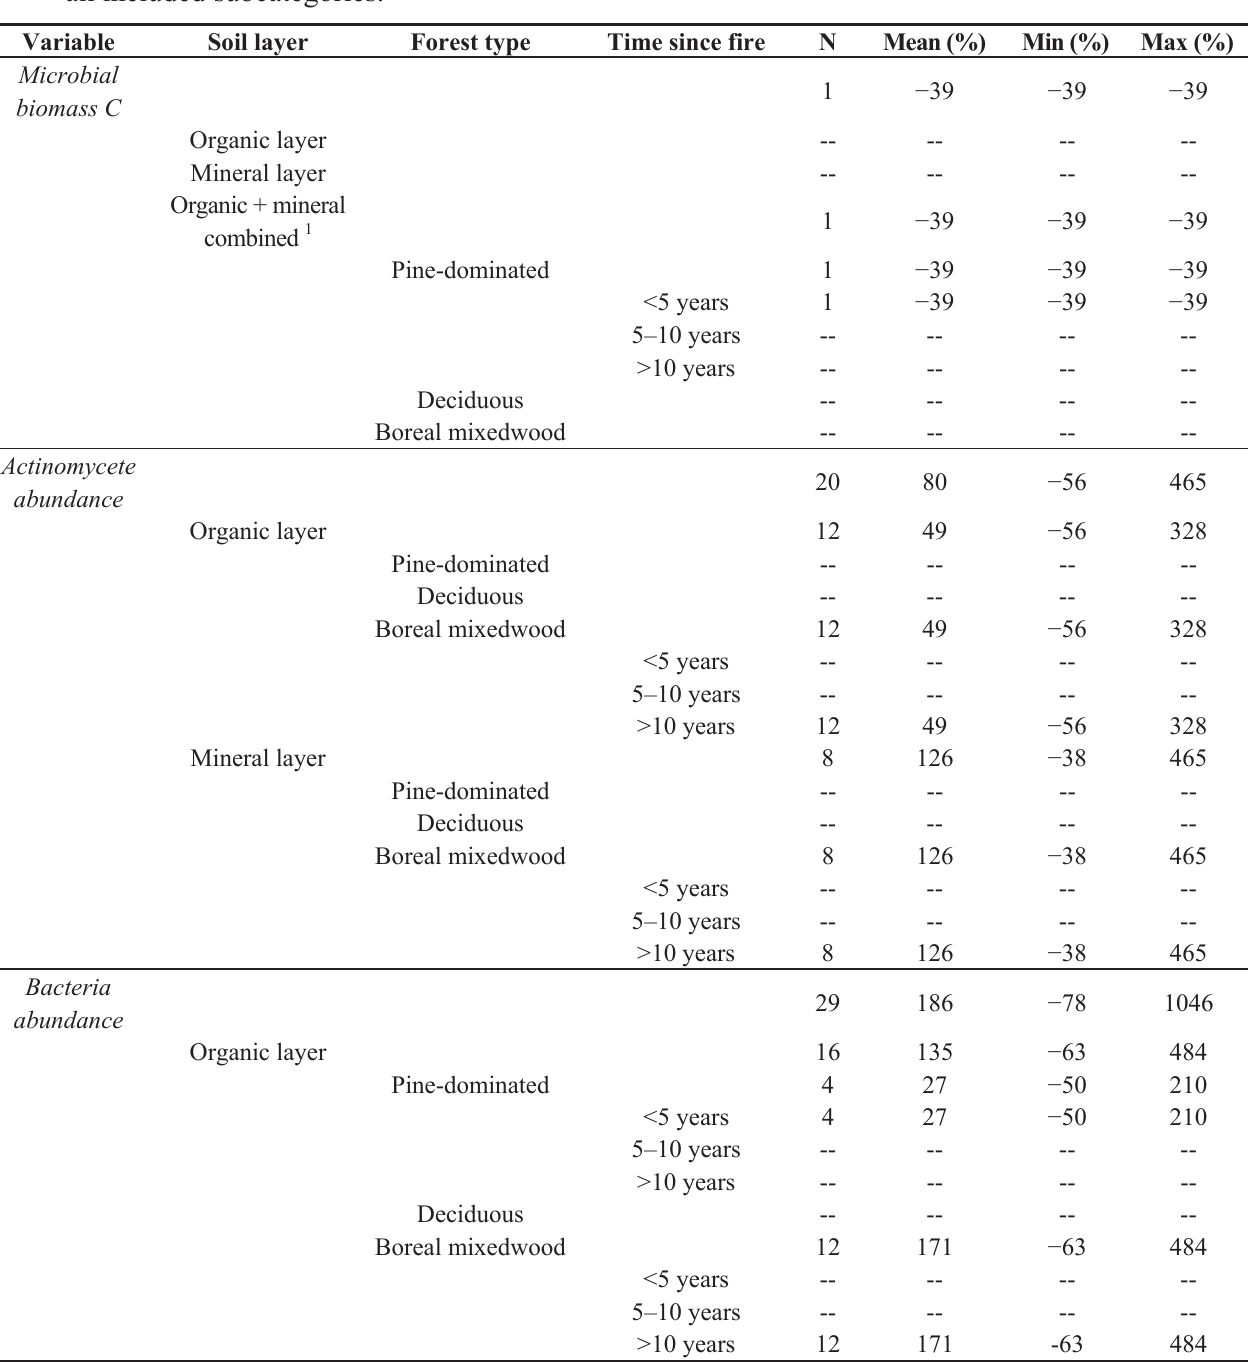
Table 7. Size and direction of fire effect on soil organisms in Lake States forests by soil layer, forest type, and time since fire. Shown are number of observations in the literature that reported measurements from burned and reference (unburned) areas, and mean, minimum and maximum percent change relative to reference areas. Categories for which no data were reported for burned and reference areas are indicated by --. Values shown in rows for each variable, soil layer, and forest type major categories were calculated across all included